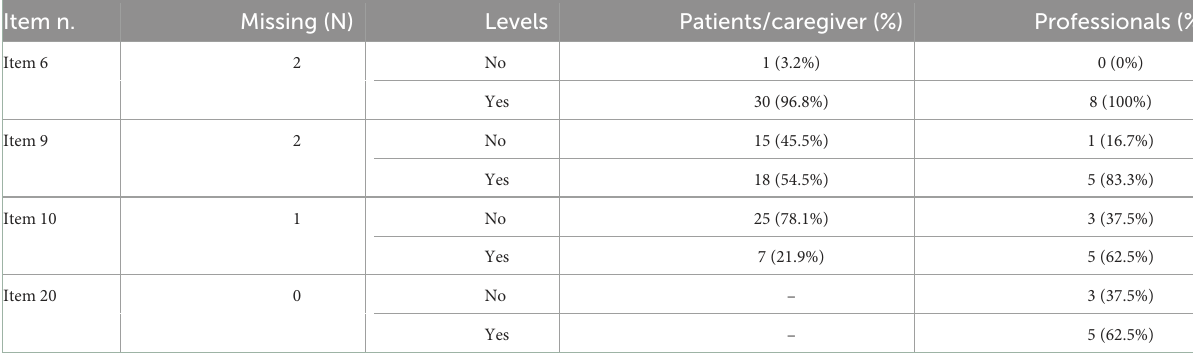
TABLE 3 Percentage of responses to dichotomic items. Item